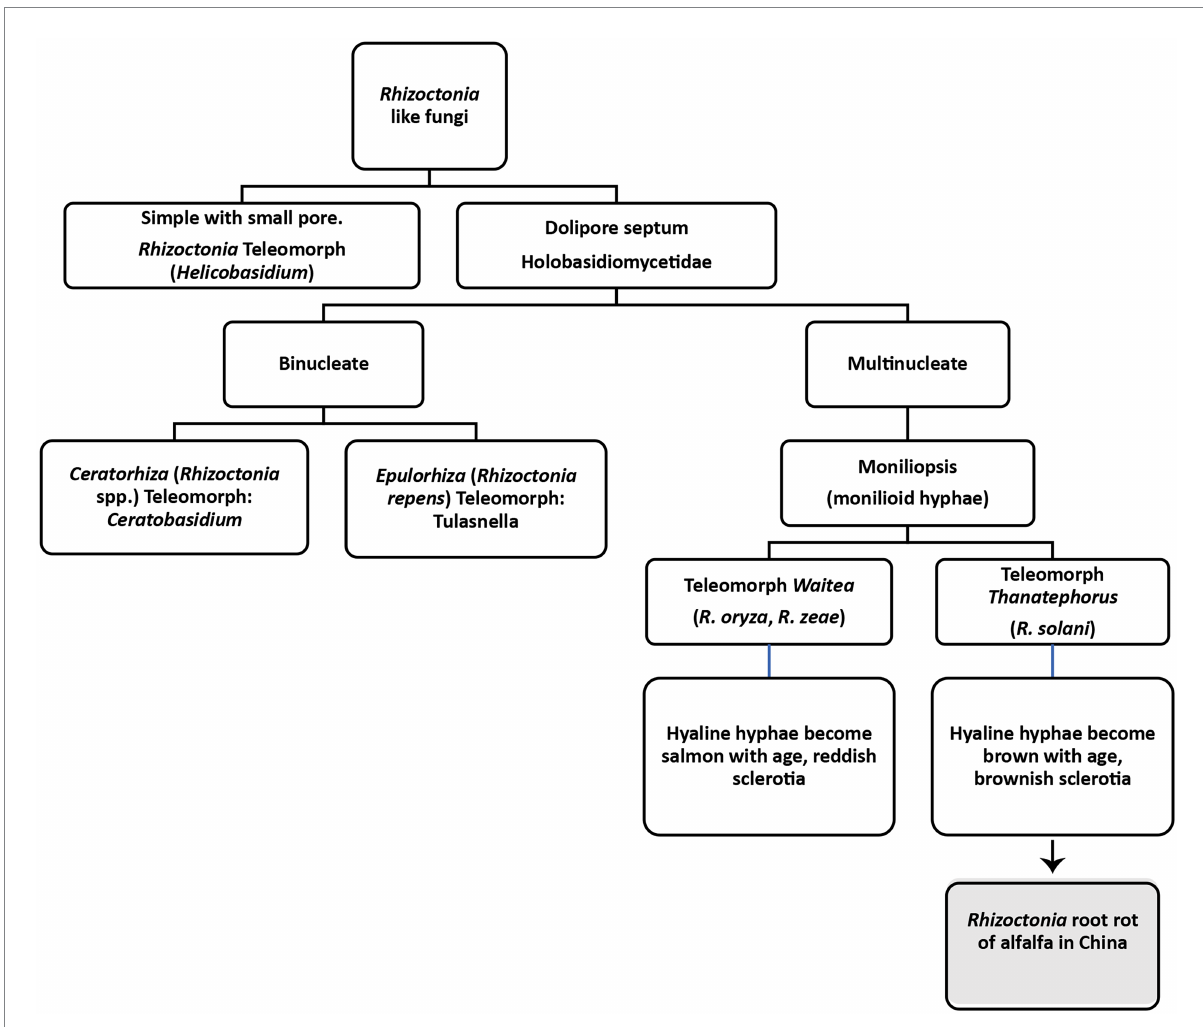
FIGURE 4 Classification of Rhizoctonia like fungi based on Moore